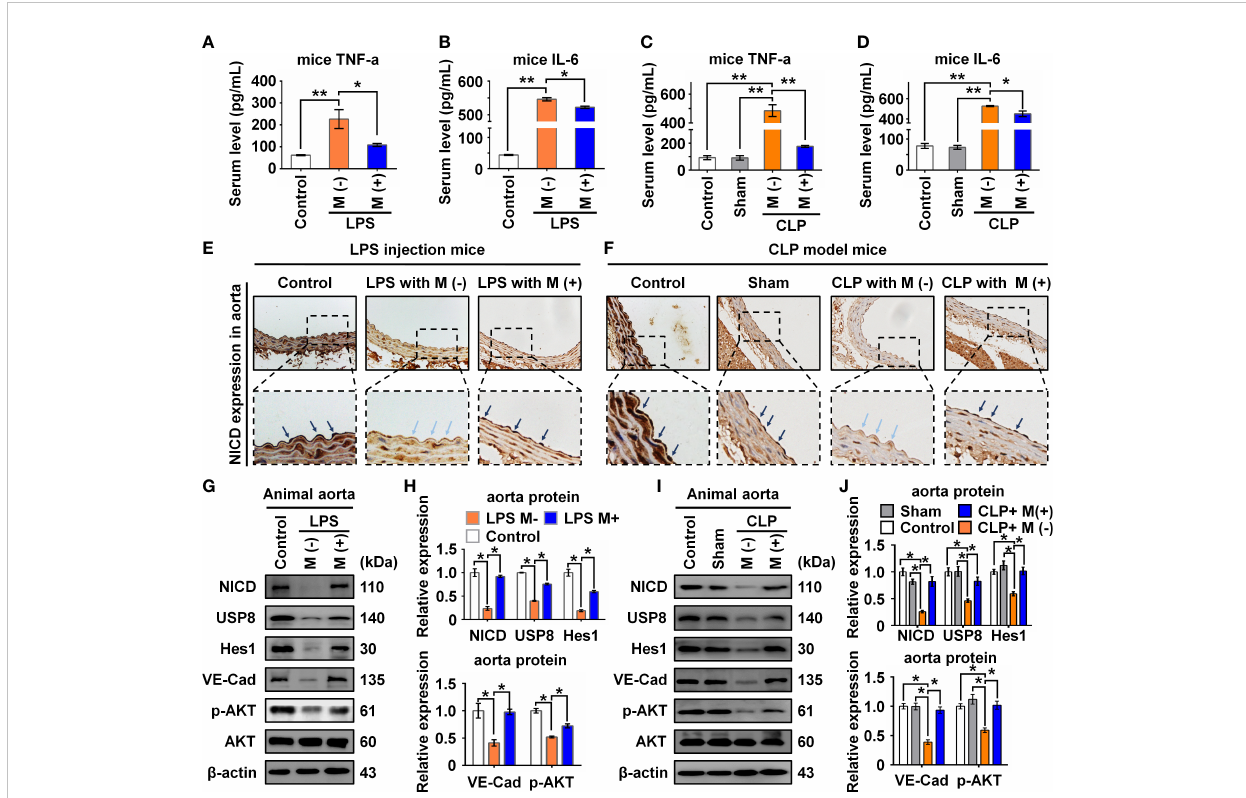
FIGURE 7 Melatonin attenuated sepsis-induced NICD downregulation in sepsis mice. (A, B) The serum levels of TNF- a (A) and IL-6 (B) in mice with the indicated treatment in LPS injection mice were detected by ELISA. (C, D) The serum levels of TNF- a (C) and IL-6 (D) in mice with the indicated treatment in CLP group were detected by ELISA. (E, F) Representative images of NICD expression in aorta tissues were detected by immunohistochemistry with indicated treatment in LPS group (E) and CLP group (F) . (G, H) The expression of NICD, USP8, Hes1, VE-Cad, and p-AKT in LPS group in aorta tissues were tested using Western blot analysis. Representative images (G) and three experiments replicates (H) were displayed. (I, J) The expression of NICD, USP8, Hes1, VE-Cad, and p-AKT in CLP group mice aorta tissues were tested using Western blot analysis. Representative images (I) and three experiments replicates (J) were displayed. Data are shown as the mean ± SEM. * p < 0.05. ** p <